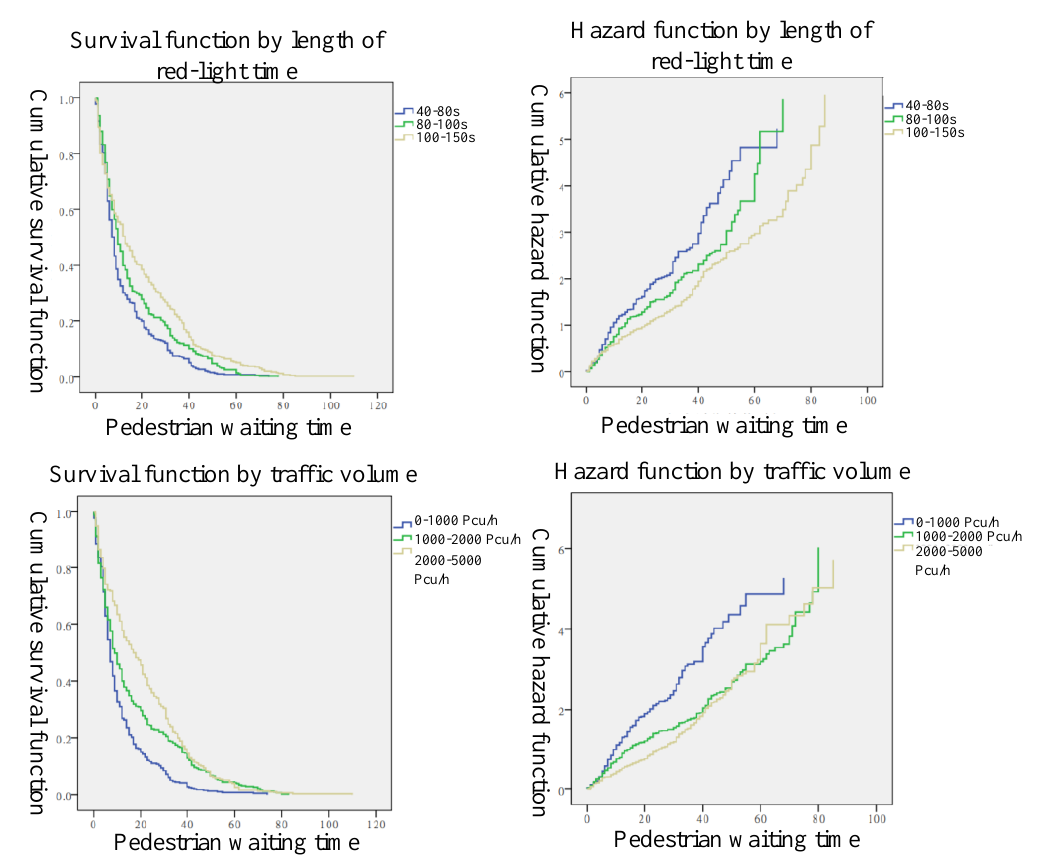
Figure 5. The survival and hazard function curves by four different lengths of red-light time and traffic volume.